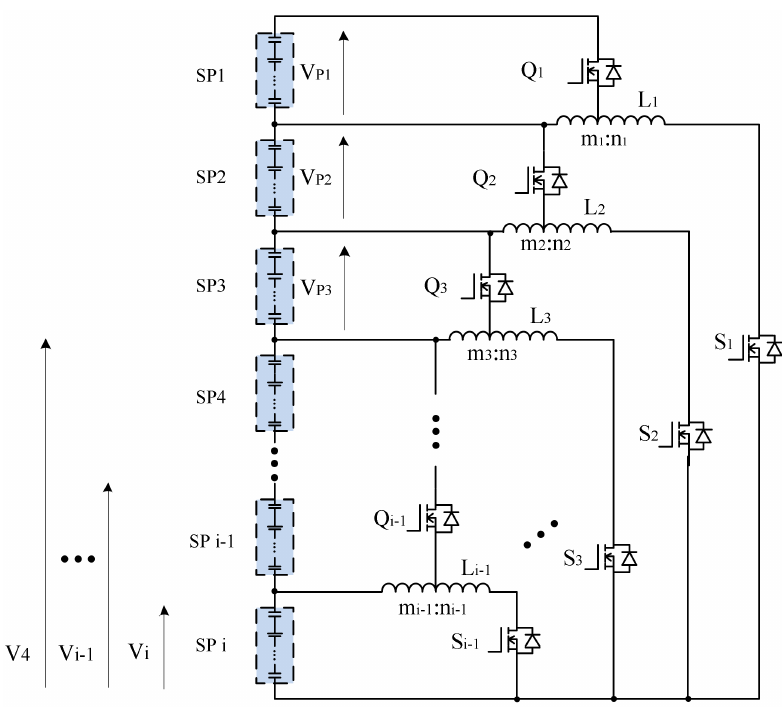
Figure 4. Generalized tapped inductor cell equalization